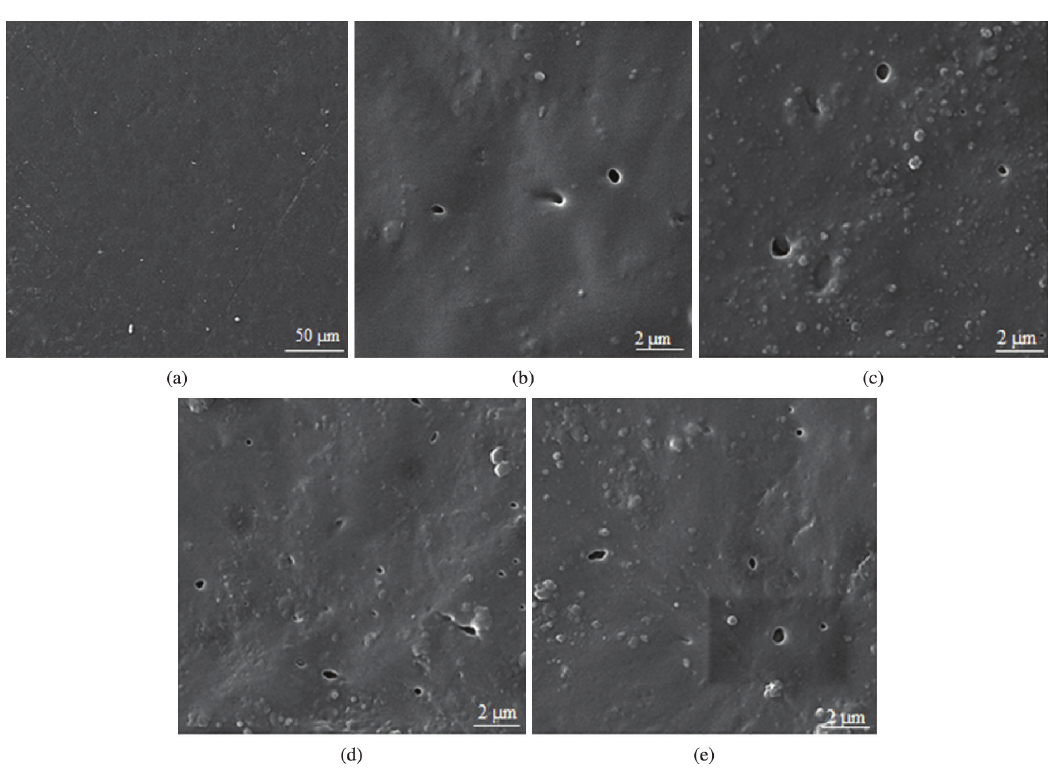
Figure 5. SEM images of Nano-composite samples after 100 h UV radiation. (a) pure PP, (b) PP5Ti, (c) PP10Ti, (d) PP30Ti and (e) PPDTi. of the films. The numbers of cavities in PP30Ti and PPDTi samples are more abundant than the PP5Ti and PP10Ti, which consist of nano-powders with a large amount of carbon, but it seems that after 100 hours of radiation, the film degradation is negligible (Figure